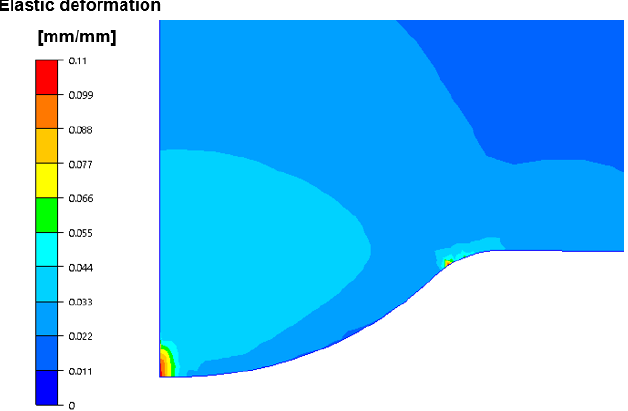
Figure 20. Distribution of plastic deformations on the punch after second forging operation.